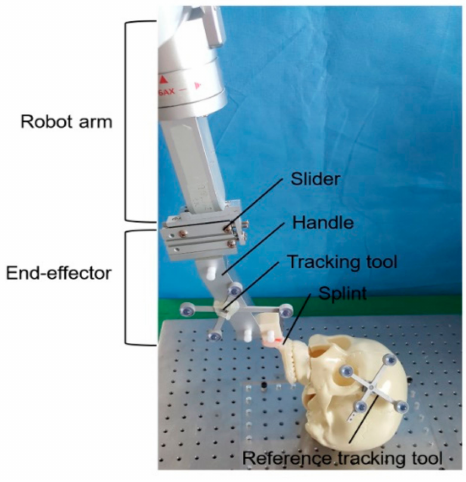
Figure 1. End-e ff ector and robot